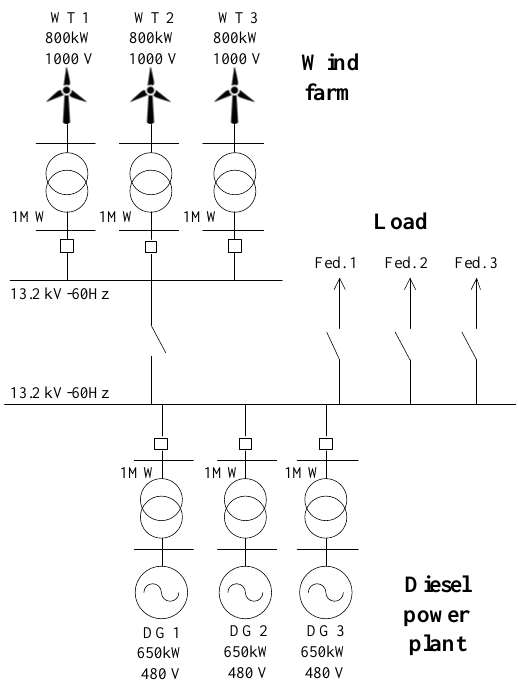
Figure 1. Single-line diagram of the San Cristobal hybrid wind-diesel power system. An imbalance between generated and demanded power of ±0.1 p.u. has been consid- ered as a disturbing event to quantitatively evaluate the impact of incorporating each of the proposed strategies on frequency stability in the system under study.